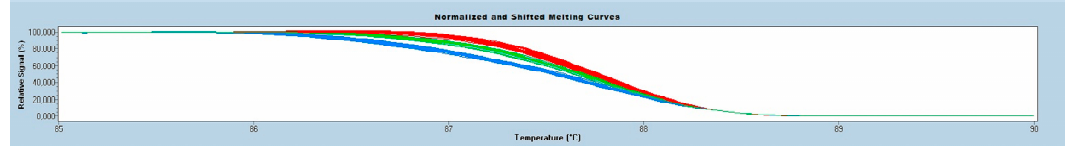
Figure 1. Normalised graph for high-resolution melting (HRM), genotype: RR—red line, RX—blue line and XX—green line.